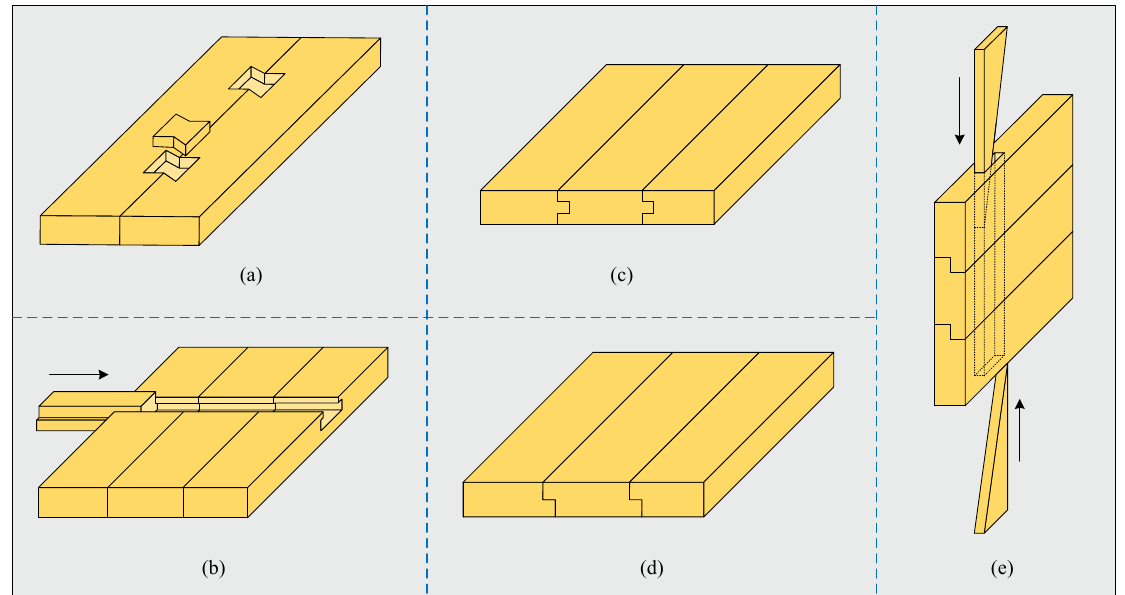
Figure 8. Tenon and mortise for joining boards. ( a ) Silver-ingot opening; ( b ) Chuandai (belting through) tenon; ( c ) Dragon and phoenix tenon; ( d ) Rabbeted joint; ( e ) Chaoshoudai.